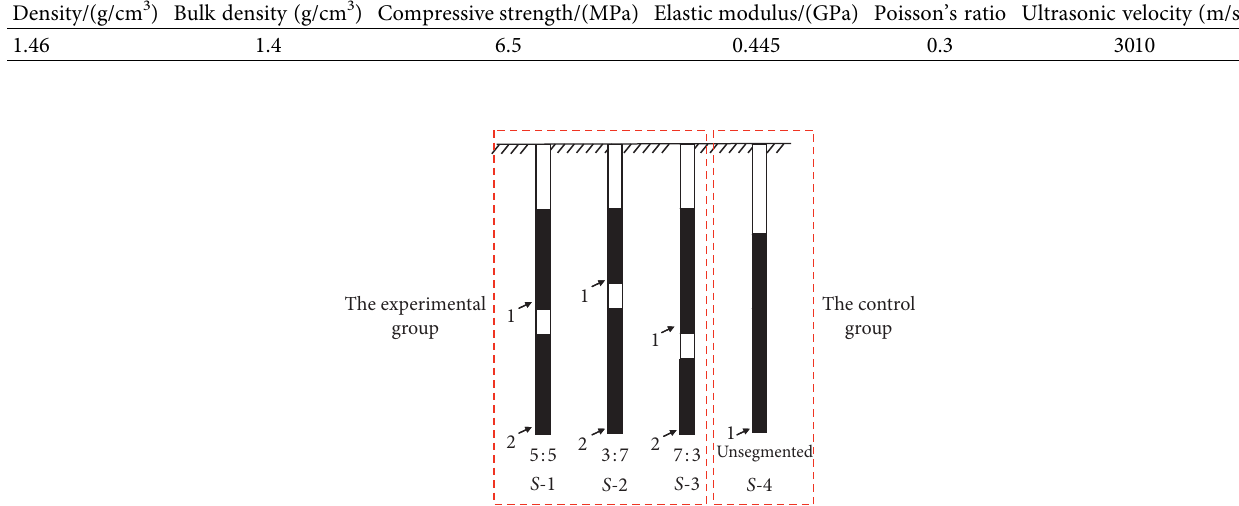
Figure 8: Order of explosion and structure of charge (the experimental group and the control group).